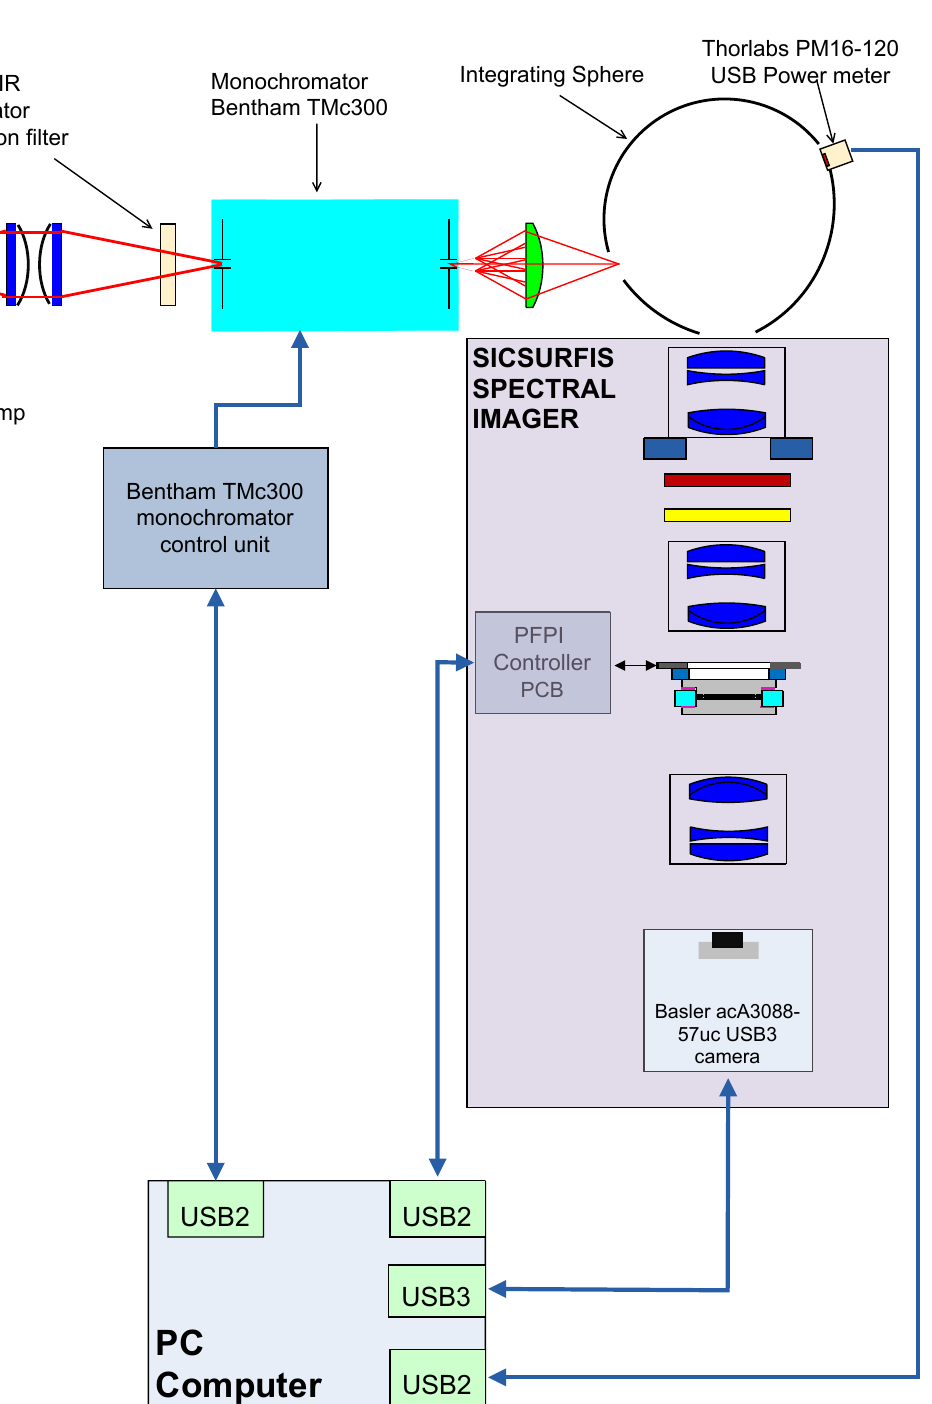
Figure 5. The SICSURFIS hyperspectral imager calibration measurement